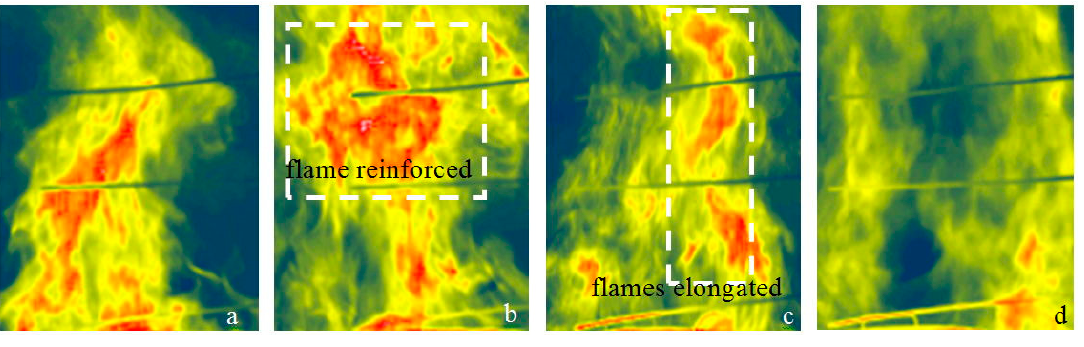
Figure 7. Comparison of the effect of the water mist, ( a ) with and ( b ) without the FeCl 2 additive, on gas combustion.